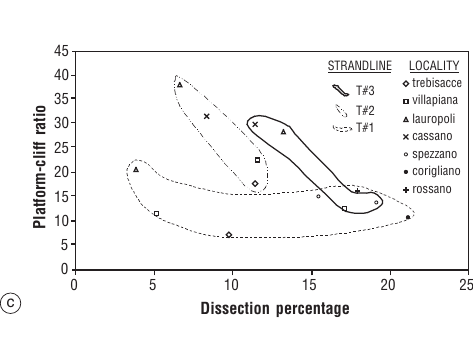
Fig. 6a-c. Geomorphological parameters of the cliff- platform systems. a) the platform-cliff ratio is the width of the terrace divided by the height of the above scarp; b) the dissection percentage is the rate between the area consumed by erosion and the initial area of the terrace. When present, T#2 is always characterized by higher values of PCR coupled with intermediate values of DP; this individuality makes the terrace a useful horizon for correlation along great distances; c) the plot of PCR against DP at seven localities of the Sibari Plain indicates a distinctive clustering of these two parameters for